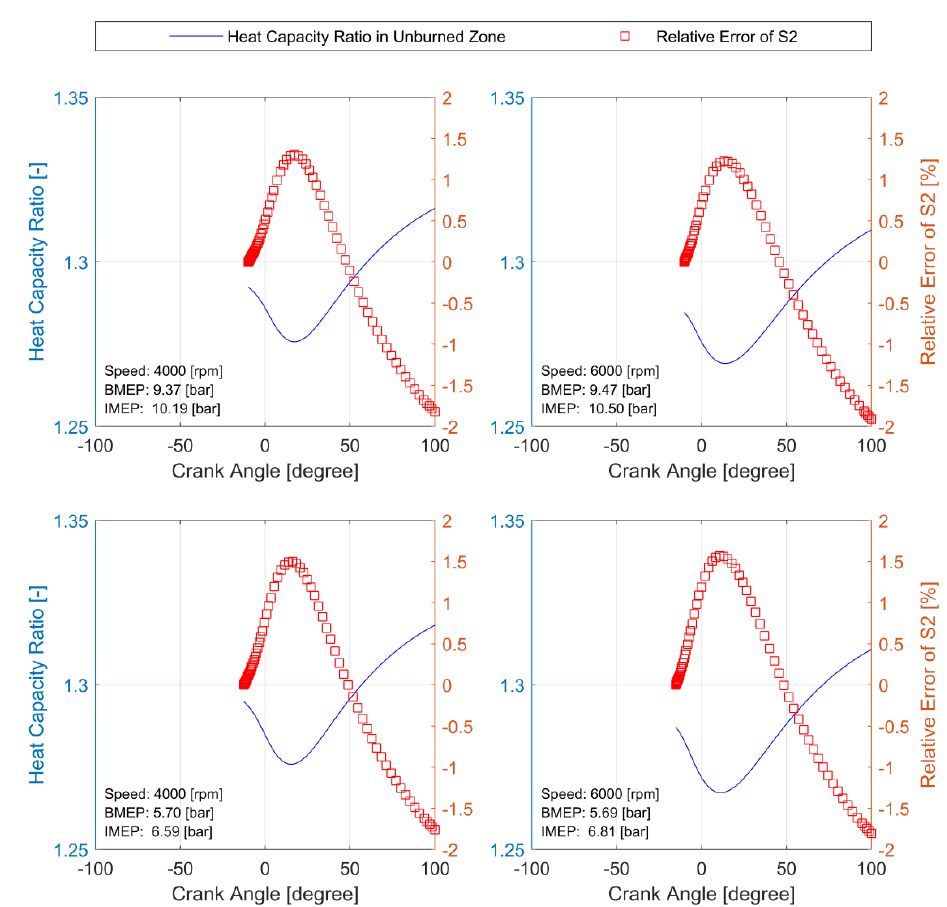
Figure 12. Heat capacity ratio of unburned zone together with the relative error of simplification S2.